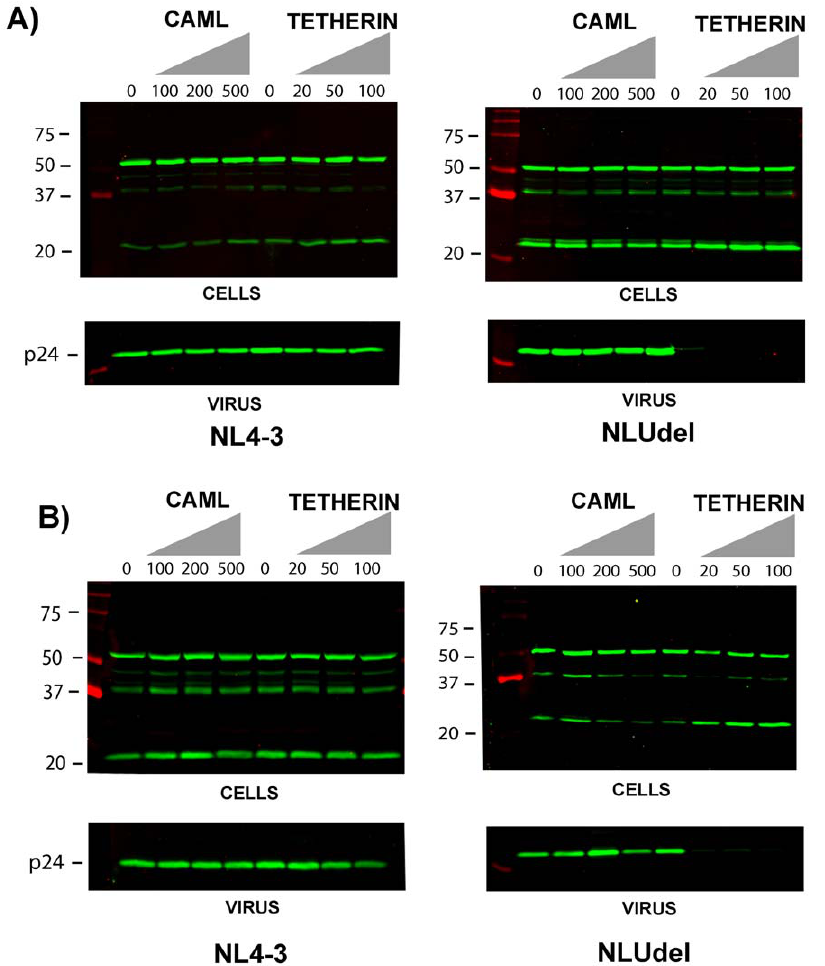
Figure 3. Direct comparison of CAML and tetherin effect on particle release in 293T cells and HT1080 cells. A) 293T cells were transfected with increasing amounts of CAML or tetherin expression vectors and NL4-3 (left) or NLUdel provirus (right). Cells and particles in supernatants were harvested at 48 hours post-transfection and analyzed by Western blotting using an anti-p24 monoclonal antibody. Total amount of transfected CAML or tetherin plasmid DNA per 35 mm 2 well is indicated above the blots. B) HT1080 cells were employed in experiments identical to those described for 293T cells. No consistent effect of CAML on virus release was noted in either cell type, while tetherin potently inhibited virus release. Molecular mass markers are indicated on the left of each panel. using shRNA, and compared them to control shRNA-transduced cells. For these experiments, we utilized the HeLa cell pool that had been depleted of CAML as shown by the Western blots in Fig. 5. Unstained and surface-stained HeLa cells are shown in Fig. 6A and B, respectively. Partial tetherin depletion was employed as a control to demonstrate the shift in cell surface staining in this experiment (control shRNA shown in grey histogram, Fig. 6B vs. tetherin shRNA, dashed lines). CAML shRNA had no measurable effect on cell surface levels of tetherin, demonstrating no shift from control shRNA-transduced popula- tion (Fig. 6C, CAML-depleted cells represented by dashed lines).